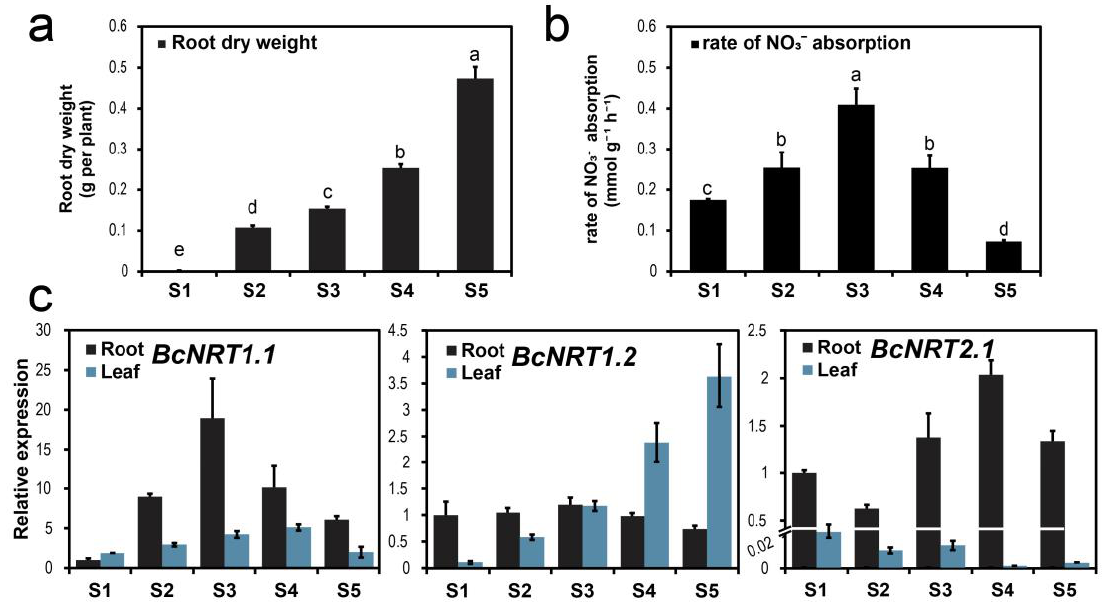
Figure 2. Roots dry weight ( a ), N absorption characteristics ( b ) and NRT genes expression pattern ( c ) of flowering Chinese cabbage during different growth periods. S1, two-leaf; S2, six-leaf; S3, bolting; S4, late bolting; S5, flowering. The housekeeping gene GAPDH was used as an internal reference gene. The data represent the mean ± SE ( n = 3). Different letters in ( a , b ) indicate significant differences at p < 0.05.